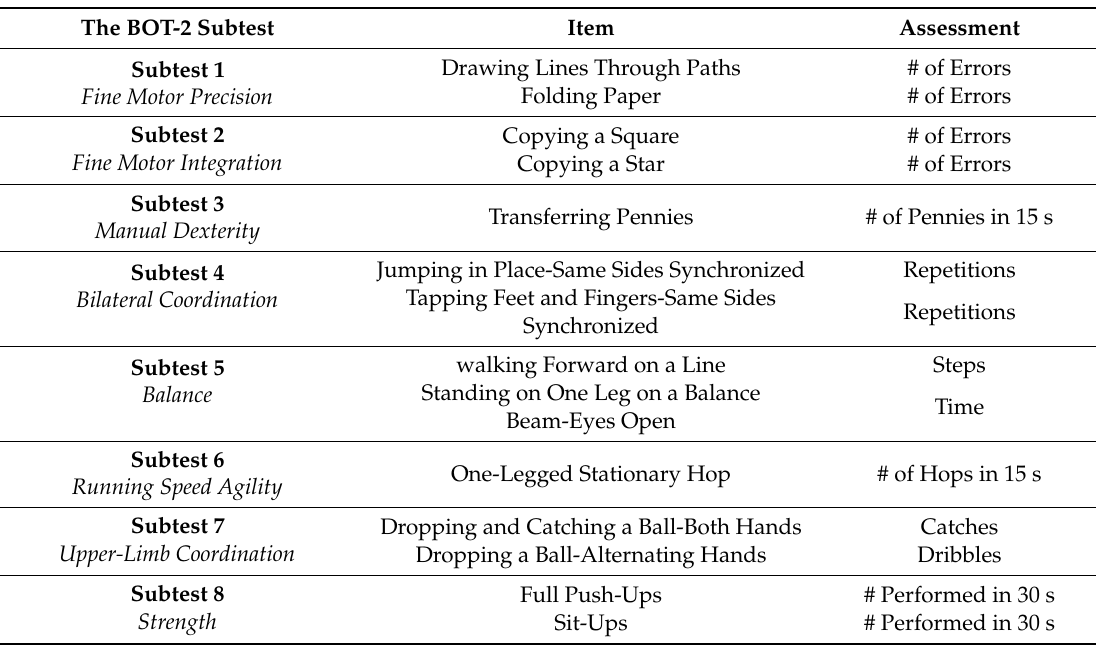
Table 2. Short-Form